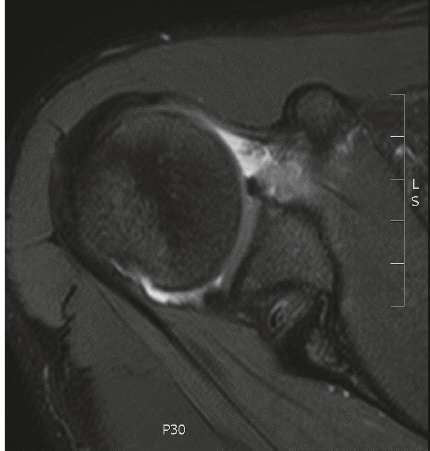
Figure 2: Axial T2 weighted MRI demonstrating absence of the bicipital groove.